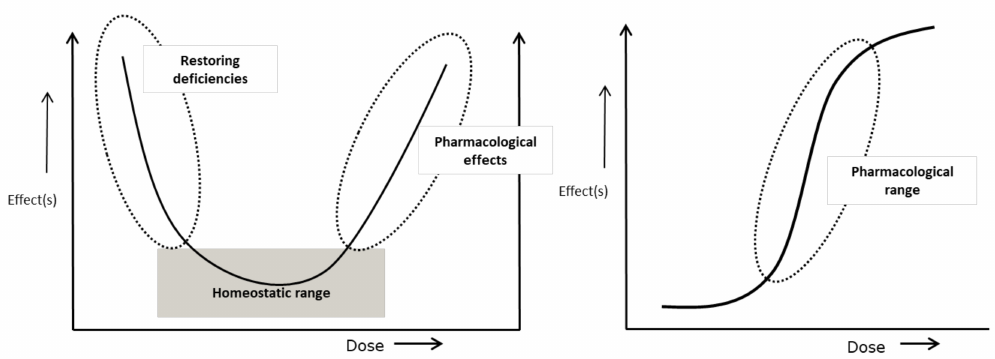
Figure 3. In contrast to most pharmacological compounds (right panel) which usually display sigmoid dose-effect behaviour, most micronutrients often show U-shaped curves. Symptoms of deficiency may be solved by adequate supply (when there are no other limiting factors). When levels are above the optimal (homeostatic) range, effects (non-nutritional or pharmacological) may occur that are often no extrapolation of their biological